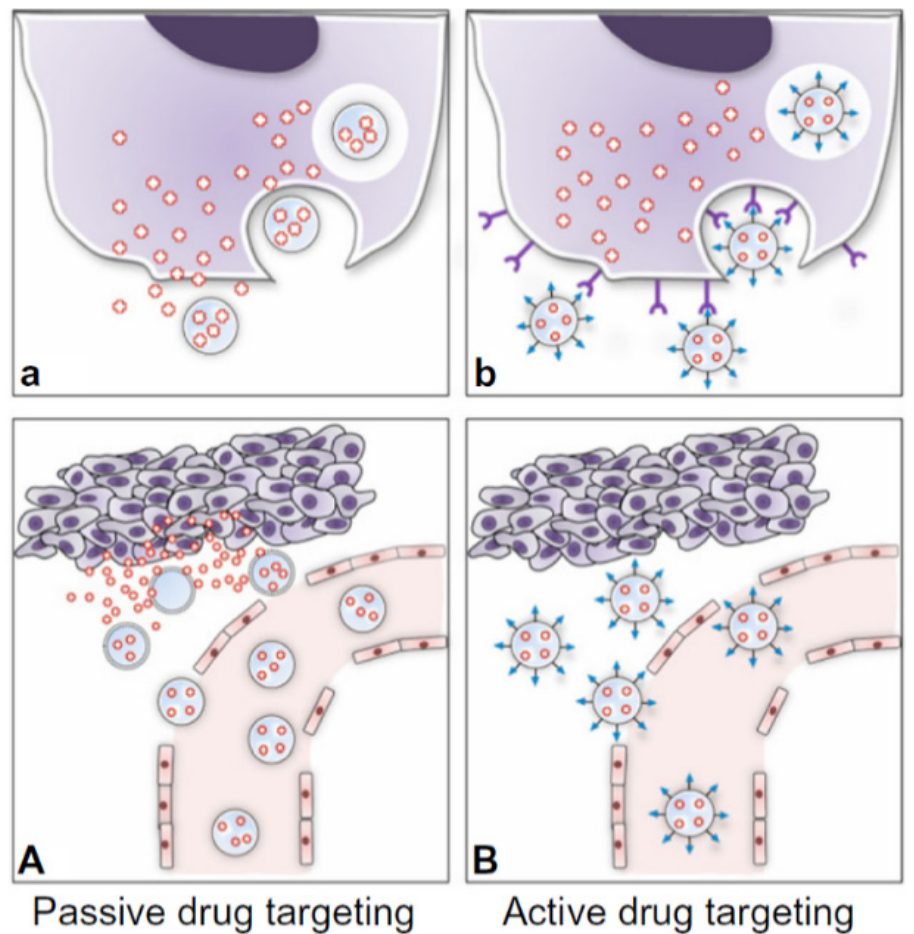
Figure 2. Drug targeting and localization of nanosystems. ( A ) Passive targeting through enhanced permeability and retention (EPR) effect and ( a ) drug releasing into the extracellular matrix (ECM), diffusing through the cell wall. ( B ) Active targeting with grafted ligands able to ( b ) target receptors of tumor cells enhancing uptake and internalization via receptor-mediated endocytosis. Reprinted with permission from Dove Medical Press [23].